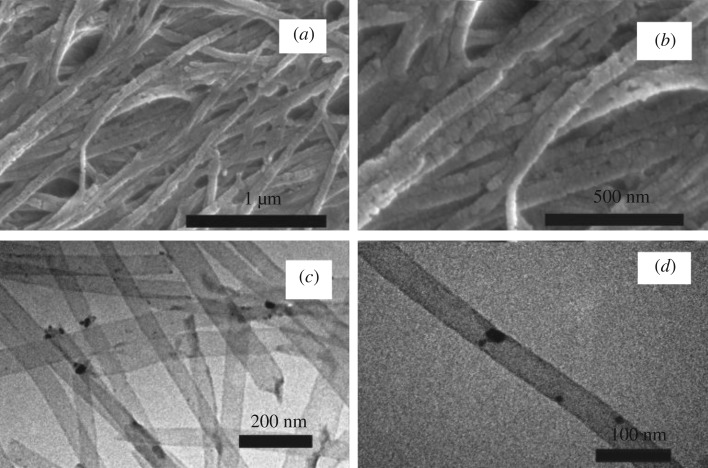
SEM images of the Cu2O/HCFs: (a) large-area view and (b) small-area view, TEM images of the Cu2O/HCFs: (c) lots of Cu2O/HCFs, (d) a single Cu2O/HCFs.